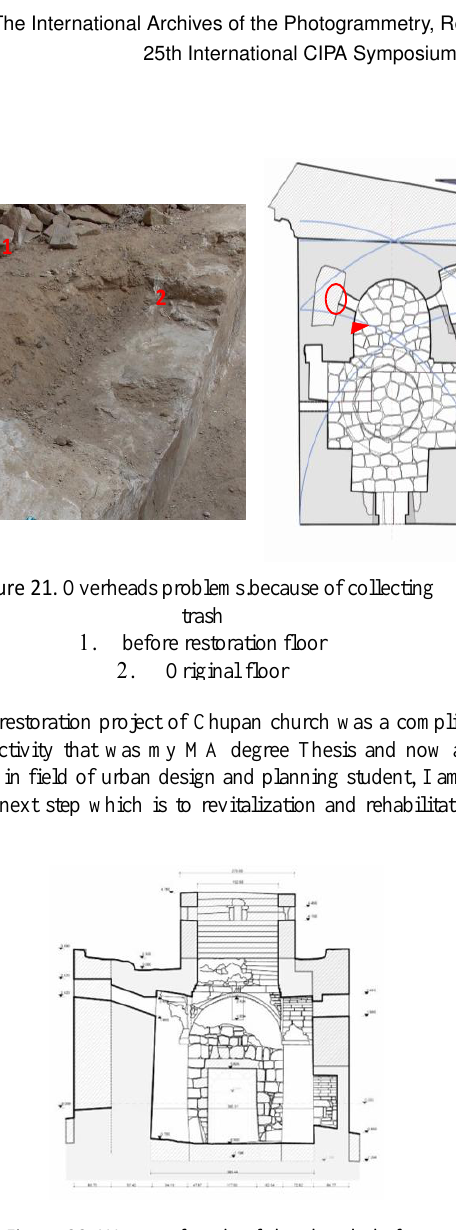
Figure 22. Western façade of the church .befor restoration